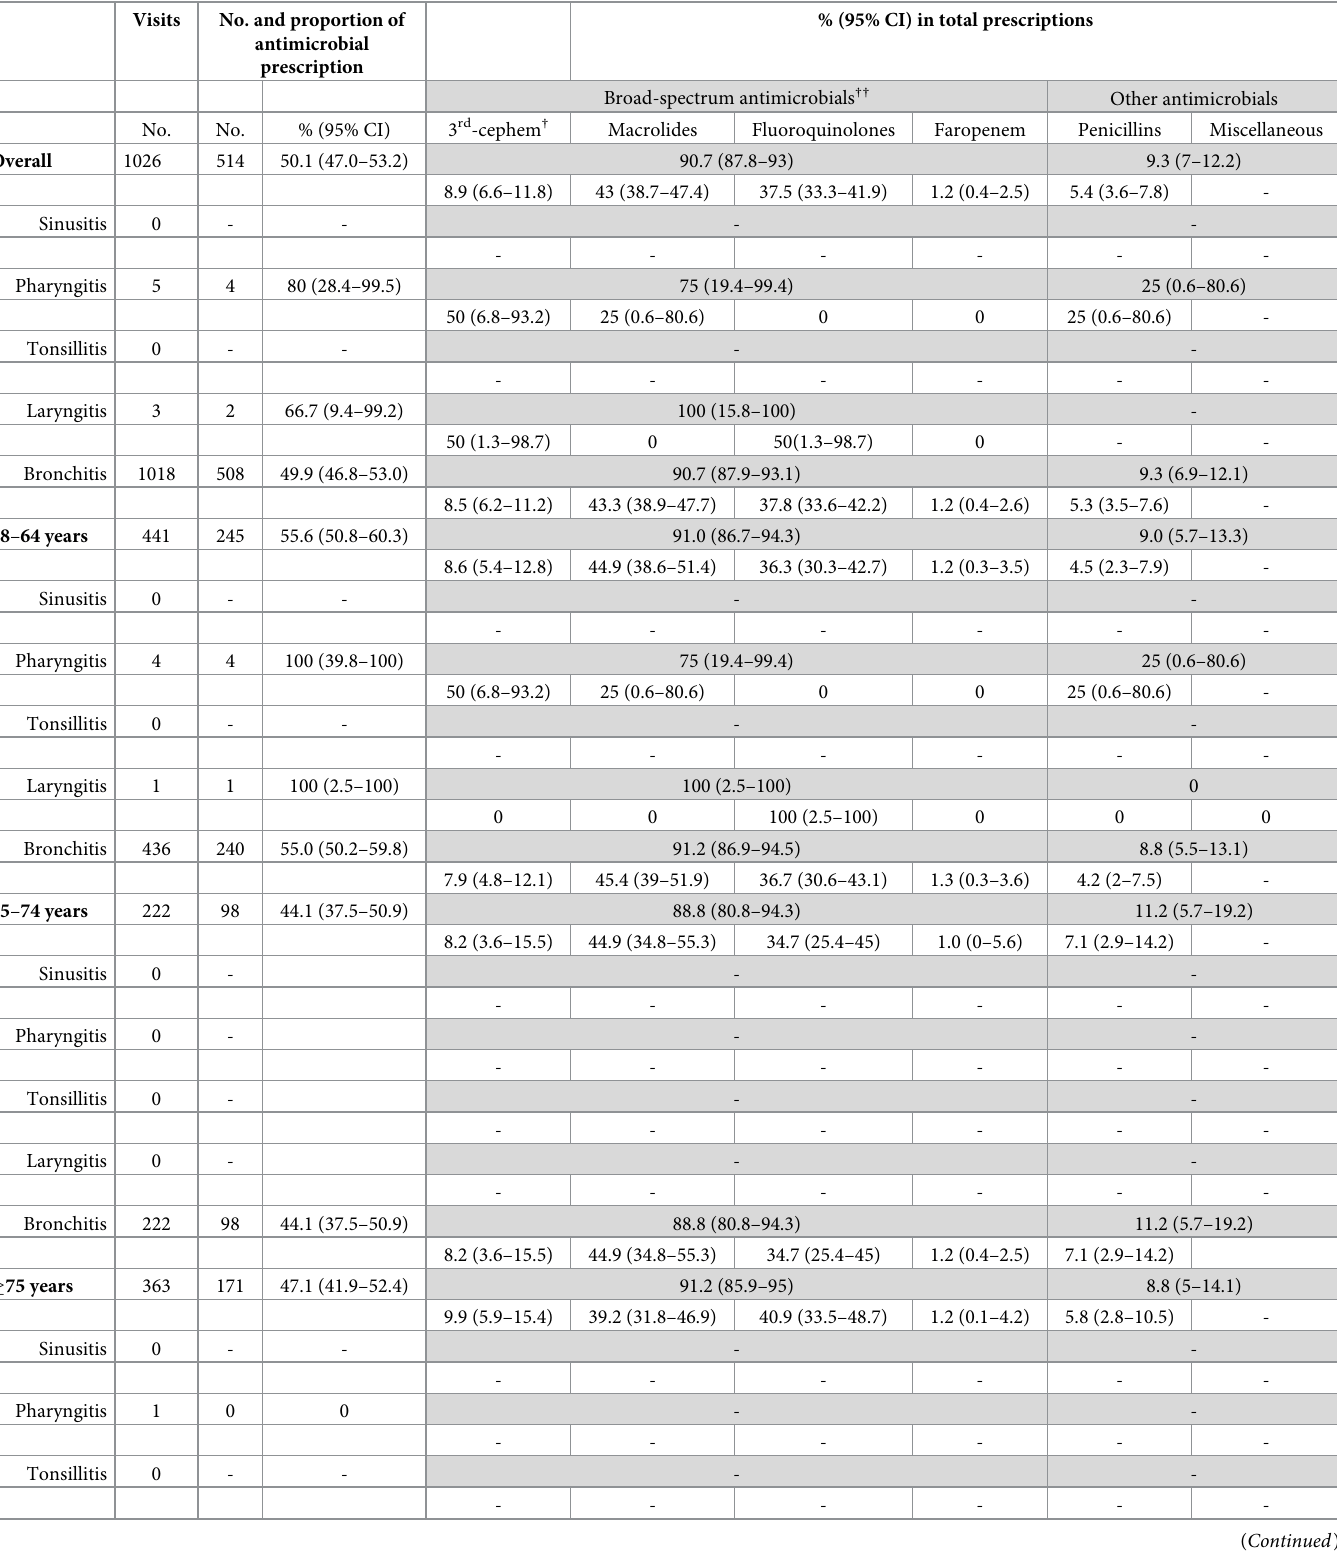
Table 4. Proportions of antimicrobial prescriptions and prescribed drugs for acute respiratory tract infections other than the common cold. Visits No. and proportion of